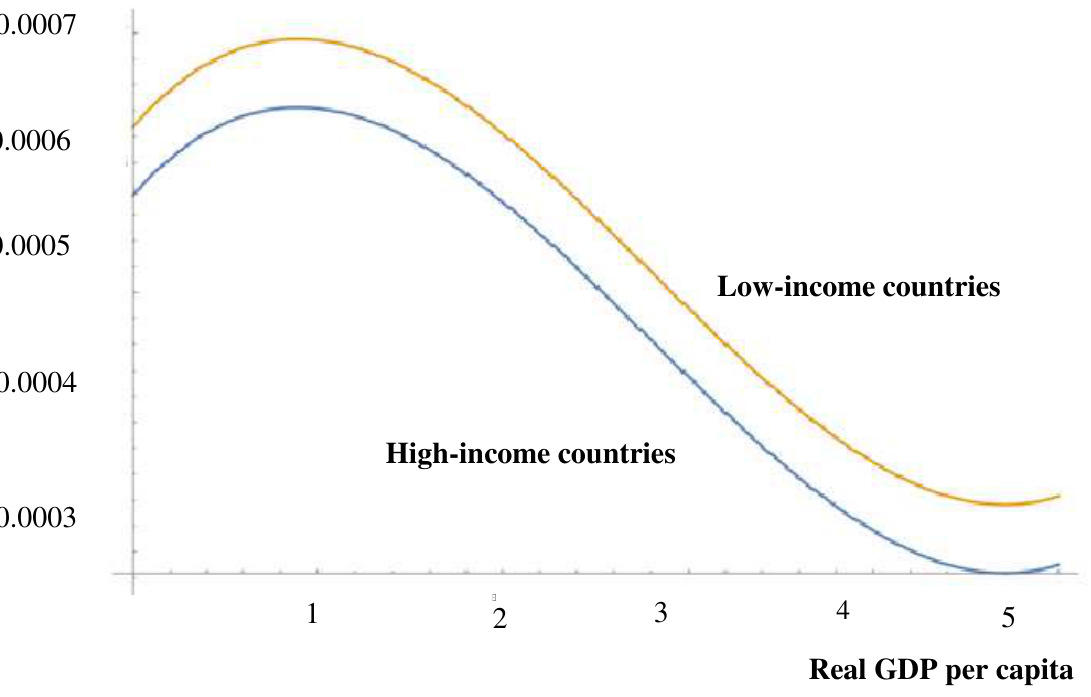
Fig. 4. Comparison of high- and low-income countries for SO 2 emissions in SEA Table 7. Income elasticity of CO